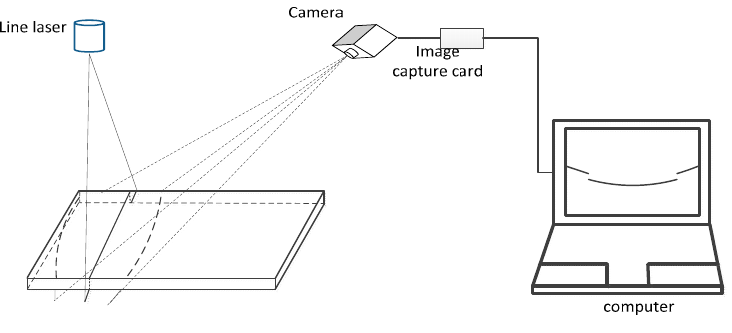
Figure 2. Image acquisition system of the fisheye.